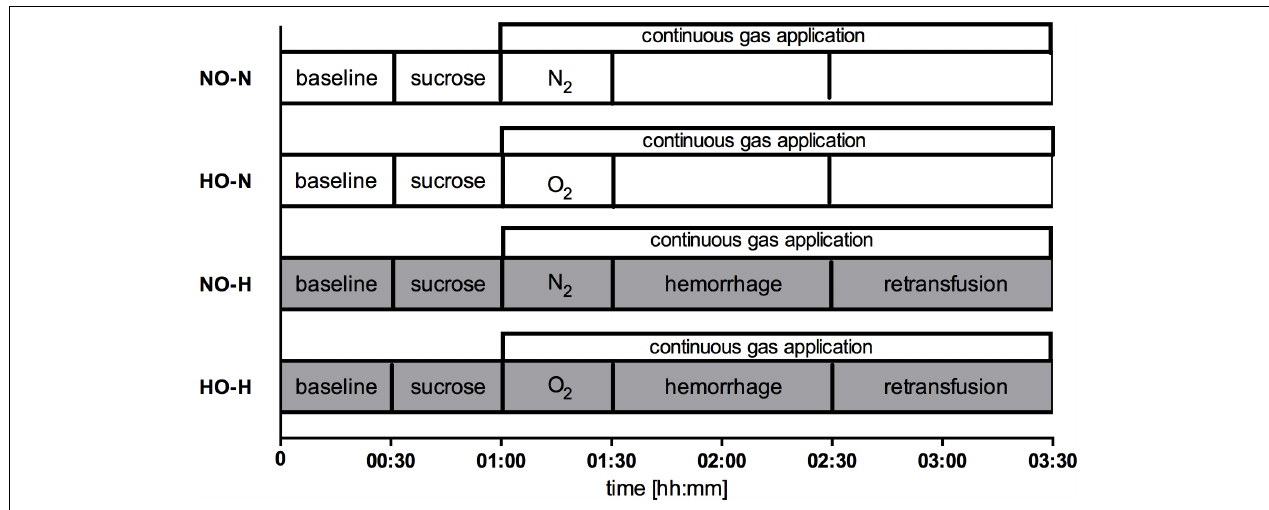
FIGURE 1 | Experimental protocol set 1: Continuous application of N 2 under normoxia (NO) or hyperoxia with application of O 2 (HO) before and during physiological (-N) or hemorrhagic (-H) condition. In shock groups 1 h of hemorrhage was followed by retransfusion, while gas application was conducted until the termination of the experimental protocol in all